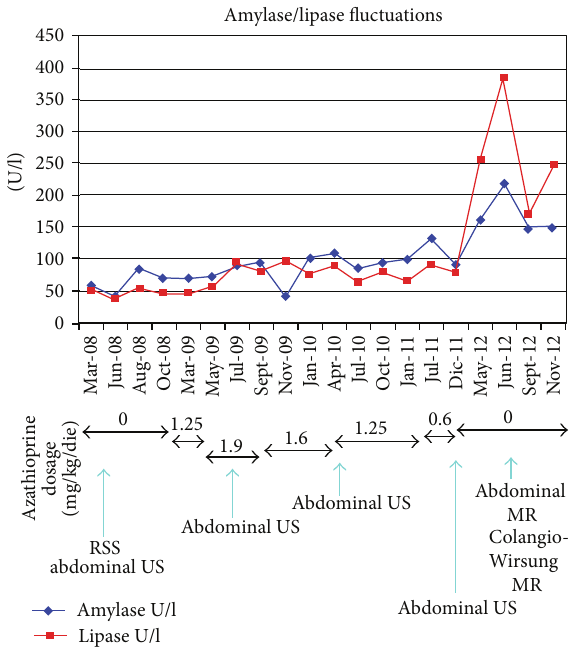
Figure 1: Amylase and lipase fluctuations. The graphic shows amylase and lipase fluctuations from March 2008 to November 2012, in correspondence with therapy modifications: AZA dosage relating to each period is reported. The blue arrows show when instrumental investigations were performed. RSS: rectosigmoidoscopy; US: ultra- sonography; MR: magnetic